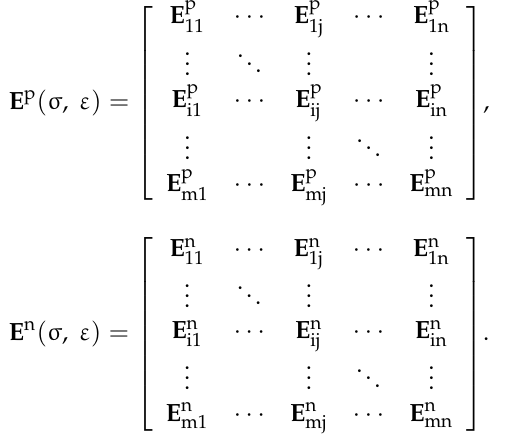
and Y-axis values—in the Y